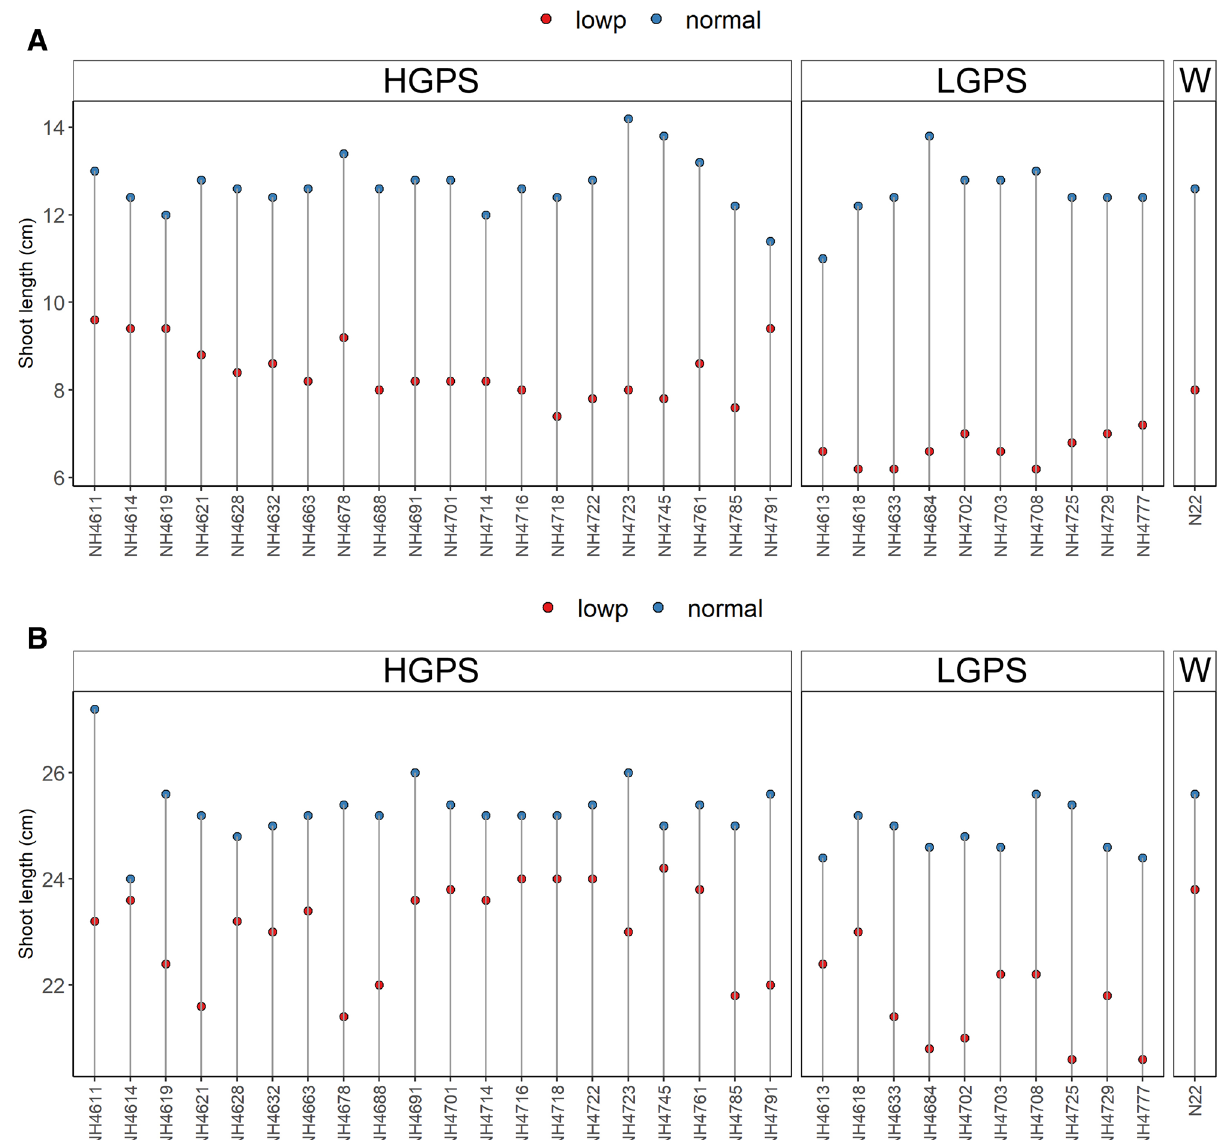
Figure 3. Shoot length of seedlings obtained from germination of seeds harvested from low P (shown as red dots) and normal P (shown as blue dots) fields. Wild type N22 (W), high grain P mutant seedlings (HGPS), and low grain P mutant seedlings (LGPS) were grown under normal P condition. ( A ) Shoot length at 12 days of germination. ( B ) Shoot length at 24 days of germination. The values represent the mean of 100